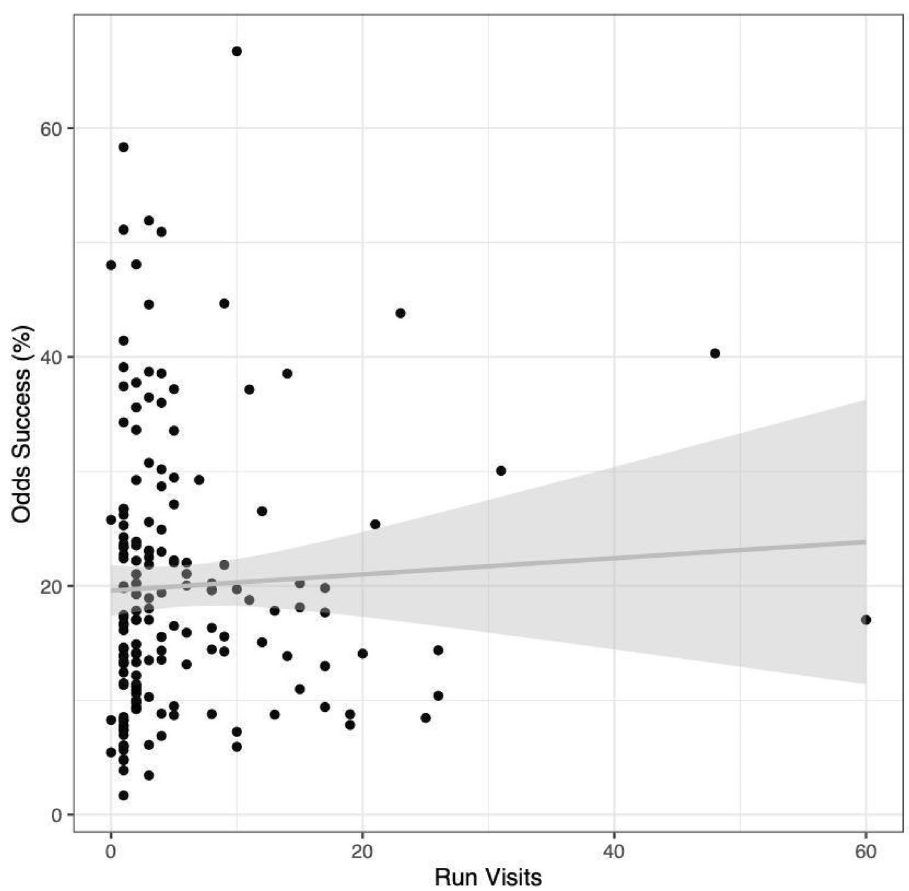
Figure 4. There is no relationship between the odds of a successful foraging attempt for each individual harbor seal (n = 170 seals) relative to run visits. The line represents a GLM of predicted odds of success by run visits with a binomial distribution based on a visits-only model (R 2 = 0.002) with a 95% confidence interval based on standard